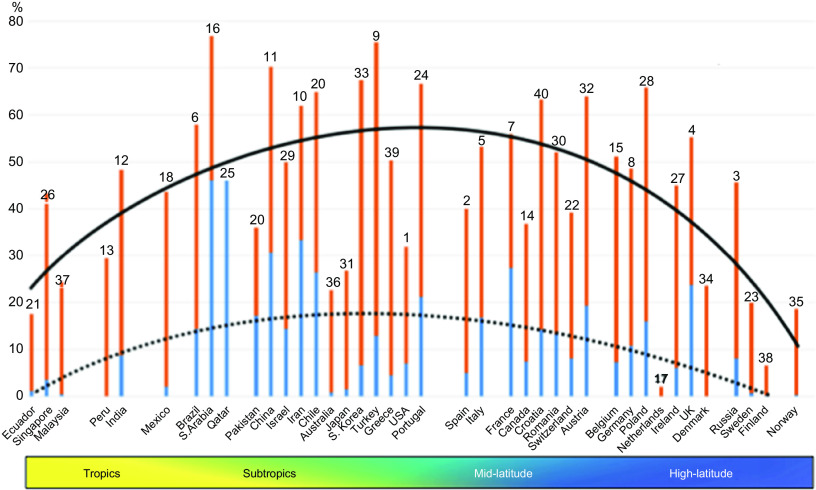
The histogram shows the prevalence of vitamin D deficiency (<50 nmol/l) and severe deficiency (<25 nmol/l) among the forty countries most commonly affected by COVID-19. The number above each column represents the country’s position in the world ranking concerning the number of total cases of infections. The colour band is a graphical representation of the four main climatic areas in the world. Regression lines show the prevalence of overall (solid black line) and severe (dotted line) vitamin D deficiencies. (), Vitamin D deficiency; (), severe vitamin D deficiency.